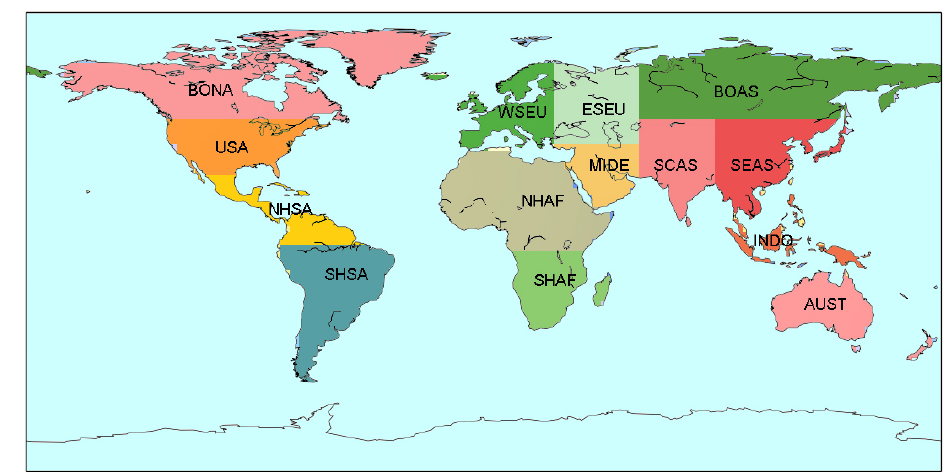
Figure A1. Sub-region